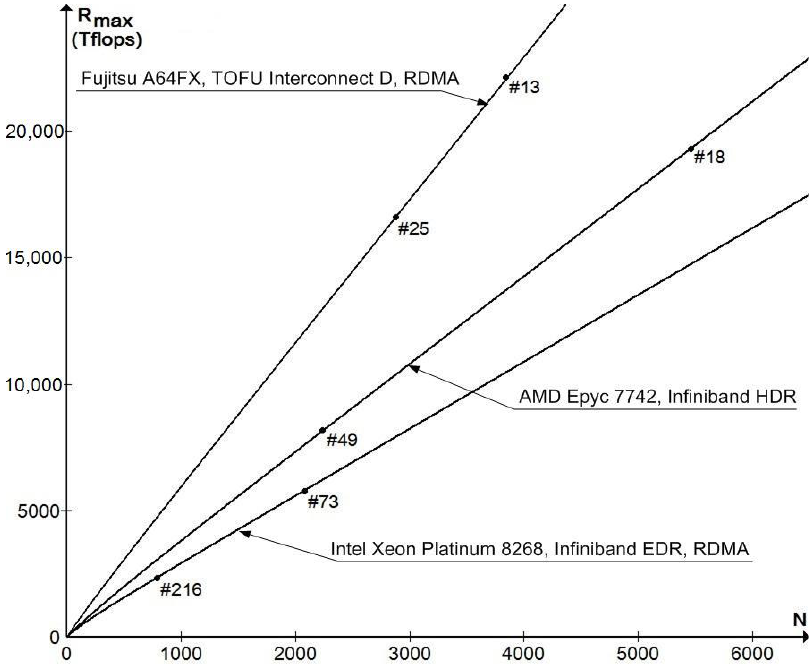
Figure 3. Examples of dependence graphs R̂ max (N) (June 2021 TOP500). Calculation error ε = |(R max − ˆR max )/R max | × 100% in comparison with the R max values given in the June 2021 TOP500 for clusters 73 and 216 does not exceed 2%.